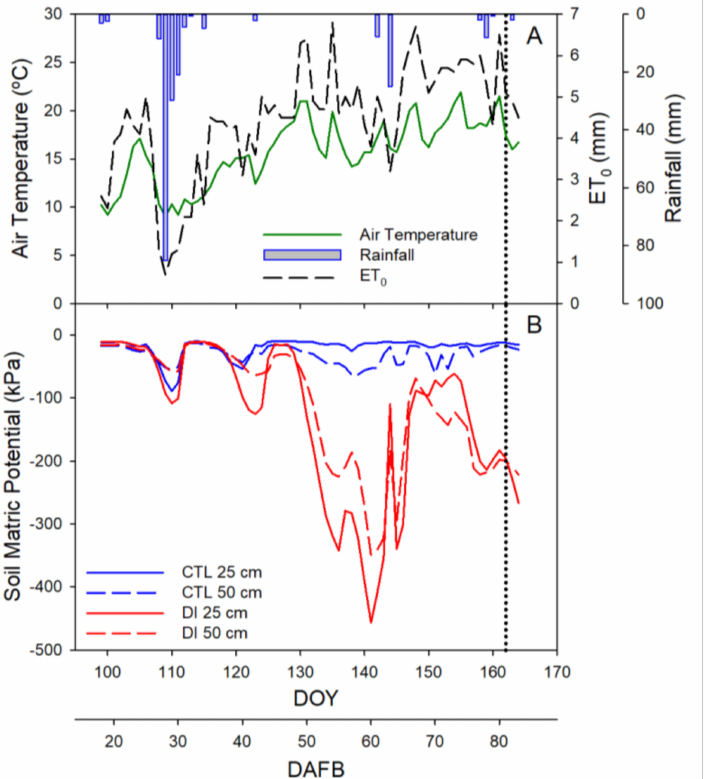
Figure 1. Seasonal evolution of environmental conditions ( A ): daily air temperature (green solid line), reference evapotranspiration (black dashed line) and rainfall (blue bars), and soil matric potential ( B ) at 0.25 m (solid line) and 0.50 m (dash line) depth for the two irrigation treatments, CTL (full irrigated treatment; blue) and DI (deficit irrigation treatment; red). The vertical dotted line indicates the harvest day (day of year, DOY 162; days after full bloom, 81 DAFB). Full bloom: 22 March 2019; harvest day: 11 June